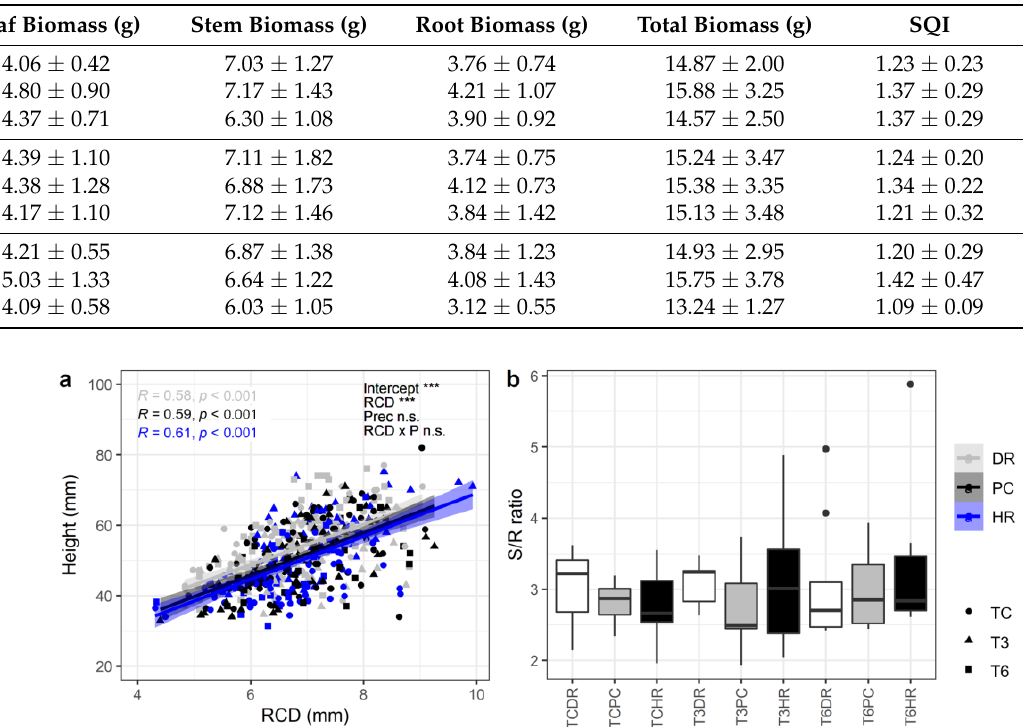
Figure 5. ( a ) Relationship between root collar diameter and height and ( b ) shoot to root ratios at the end of the treatment of L. kaempferi seedlings subjected to extreme climate events. TC: ambient temperature, T3: +3 °C warming, T6: +6 °C warming, DR: drought, PC: ambient precipitation, HR: heavy rainfall. Results from the ANOVA and Pearson correlation analysis are shown in panel ( a ). Asterisks indicate significant differences between warming treatments. Different letters indicate significant differences between treatments. The boxes’ lower and upper limits indicate the 25% and 75% quartile, respectively. Bold lines within the boxes indicate the median, whiskers indicate the range of values from the minimum to maximum, and data points beyond the end of the whiskers are then plotted as filled dots.